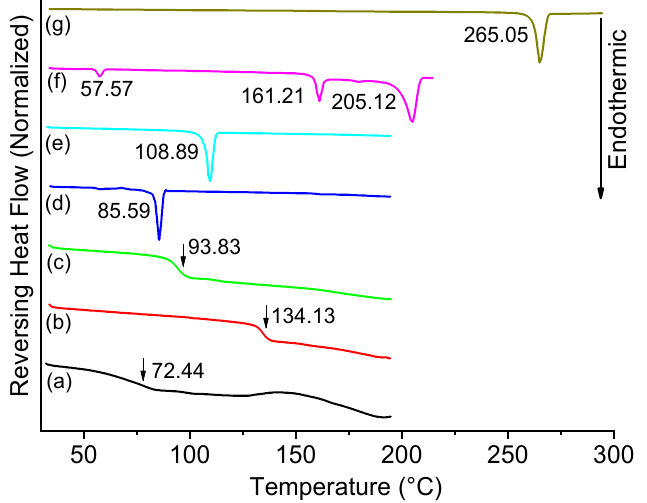
Figure 2. The mDSC curves of co-amorphous forms of MAR-RES (a), OMAR-RES (b), and SPD-RES (c), as well as crystalline forms of matrine (d), oxymatrine (e), sophoridine (f), and resveratrol